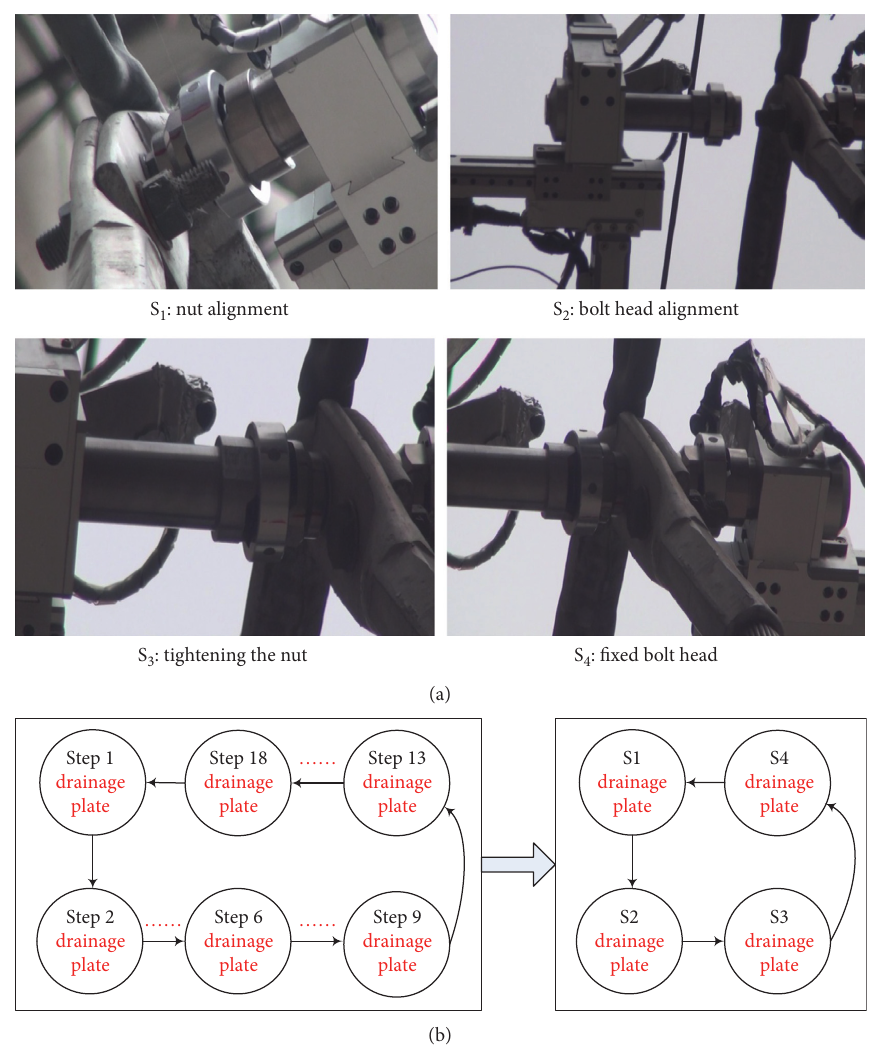
Figure 15: Field autonomous behavior control of drainage plate maintenance robot. (a) Drainage plate operation main process. (b) Drainage plate operation FSM